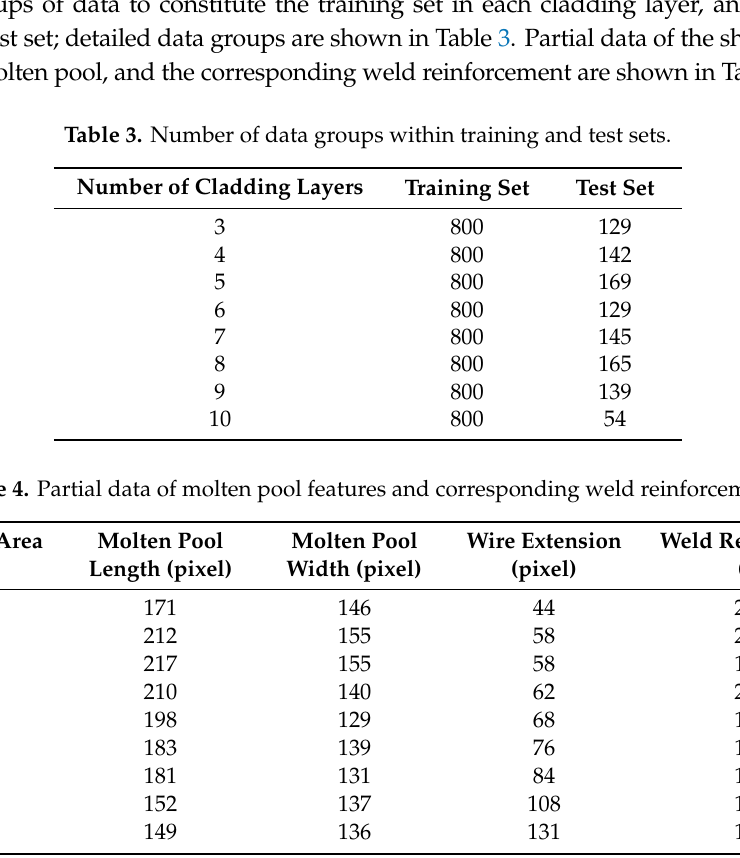
Table 4. Partial data of molten pool features and corresponding weld reinforcement.